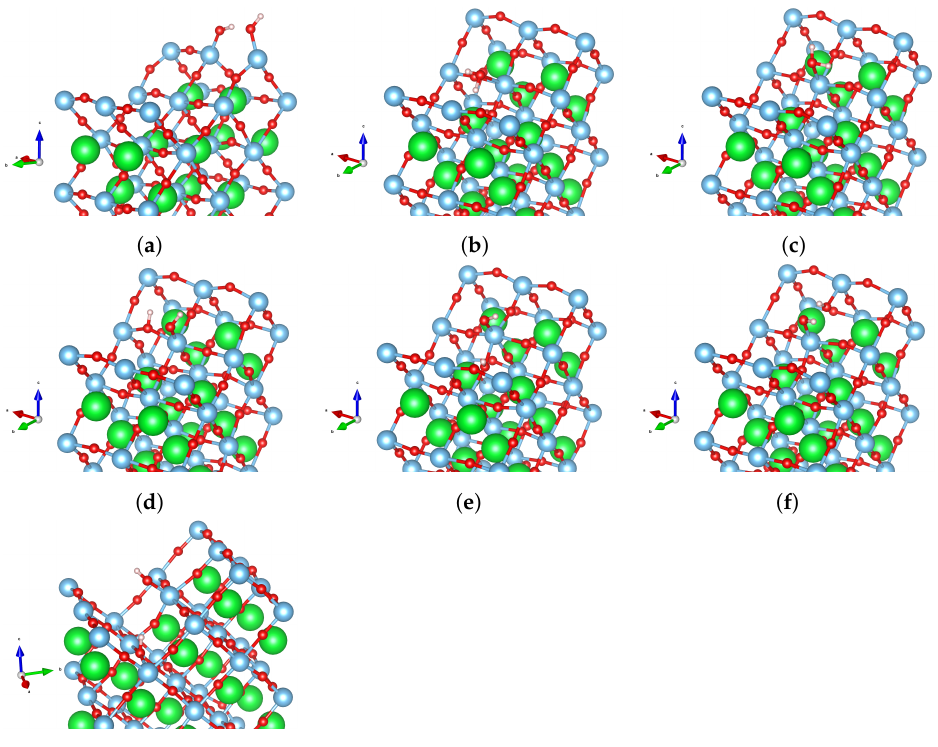
Figure 4. Water adsorption configurations on the stepped surface. ( a ) Adsorption on the ridge region. E ads = − 1.50 eV. ( b ) Molecular adsorption on the slope region with water oriented towards the gully. E ads = − 0.76 eV. ( c ) Molecular adsorption on the slope region with water oriented towards the ridge. E ads = − 0.71 eV. ( d ) Dissociative adsorption on the slope region with hydrogen migrated along the slope. E ads = − 0.83 eV. ( e ) Dissociative adsorption on the slope region with hydrogen migrated towards the gully. E ads = − 0.62 eV. ( f ) Dissociative adsorption on the slope region with hydrogen migrated towards the ridge. E ads = − 0.41 eV. ( g ) Dissociative adsorption on the gully region. E ads = − 0.49